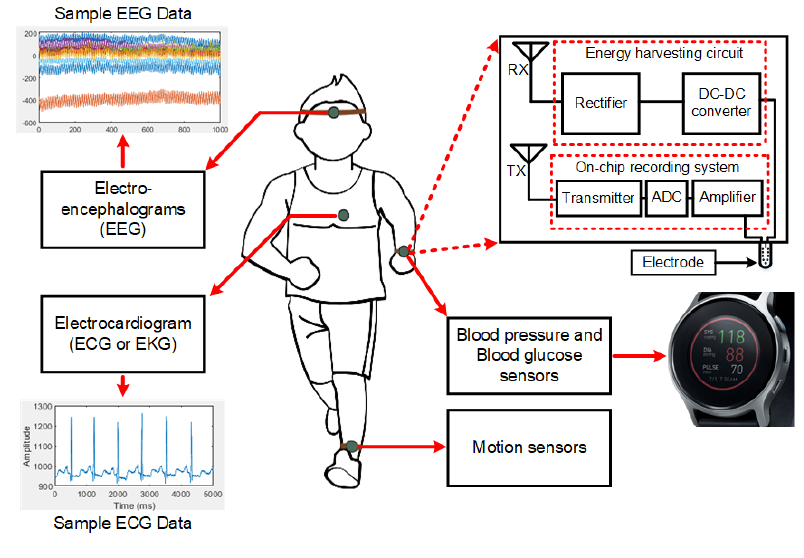
Figure 1. Wirelessly powered wearable sensor